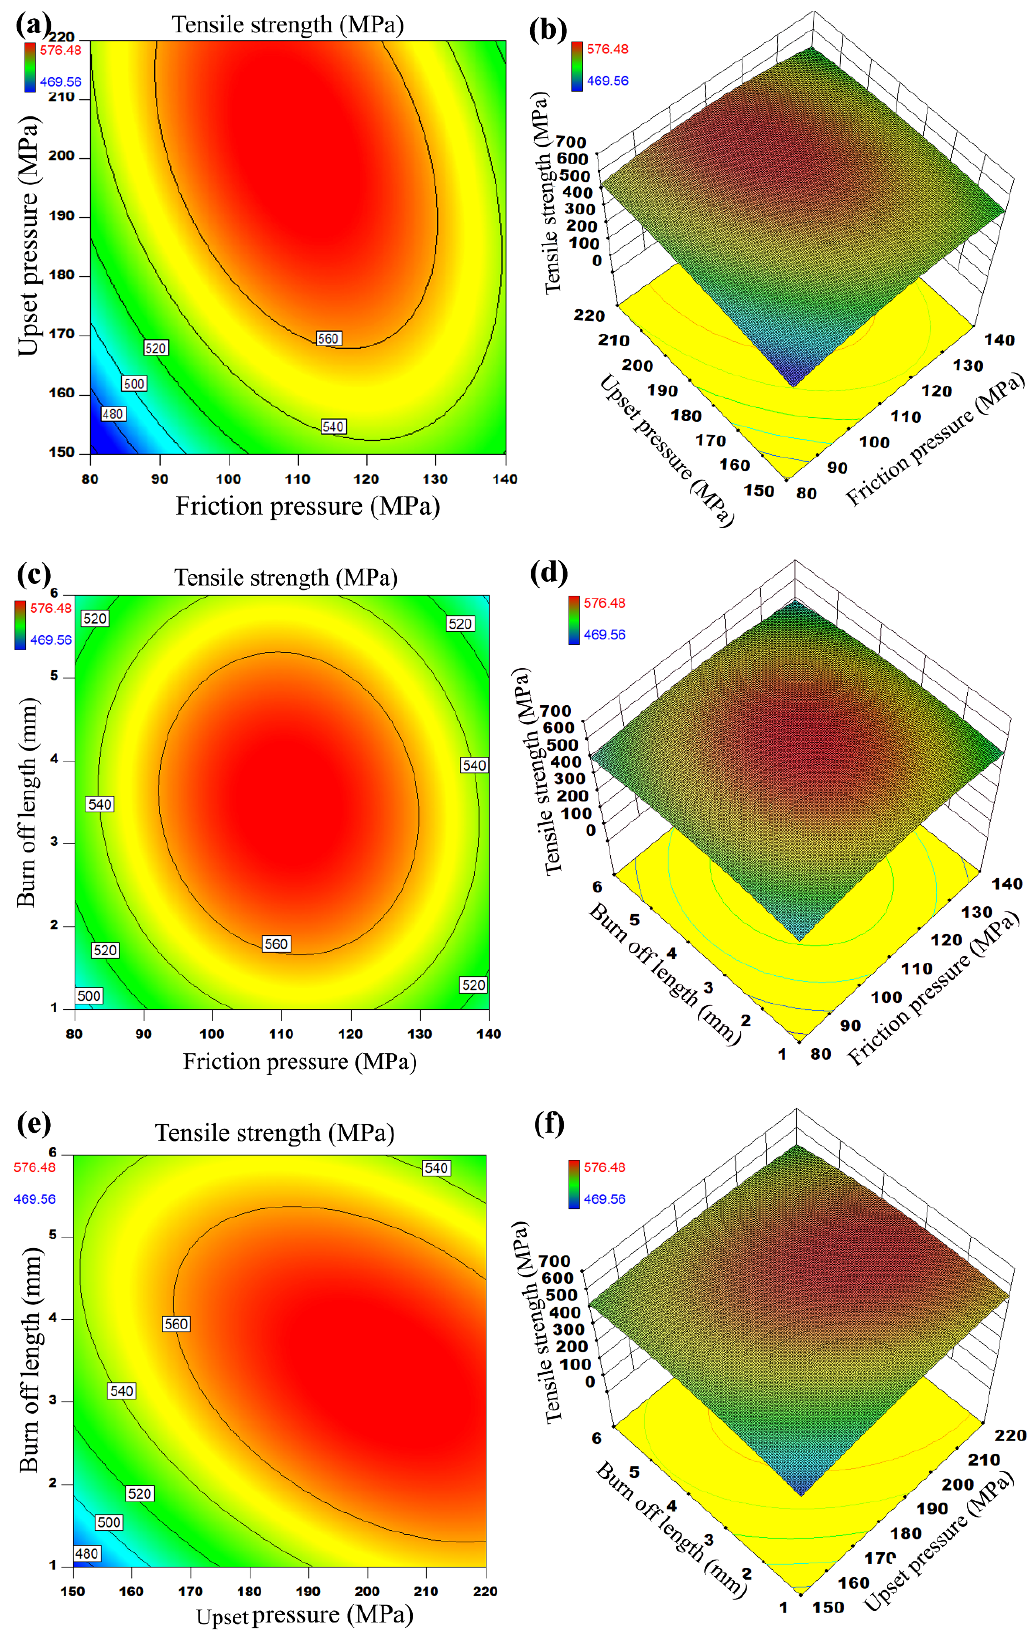
Figure 4. The effect of welding conditions on tensile strength graphs ( a , c , e ) Contour plots (2D), and ( b , d , f ) are response surface graphs (3D).